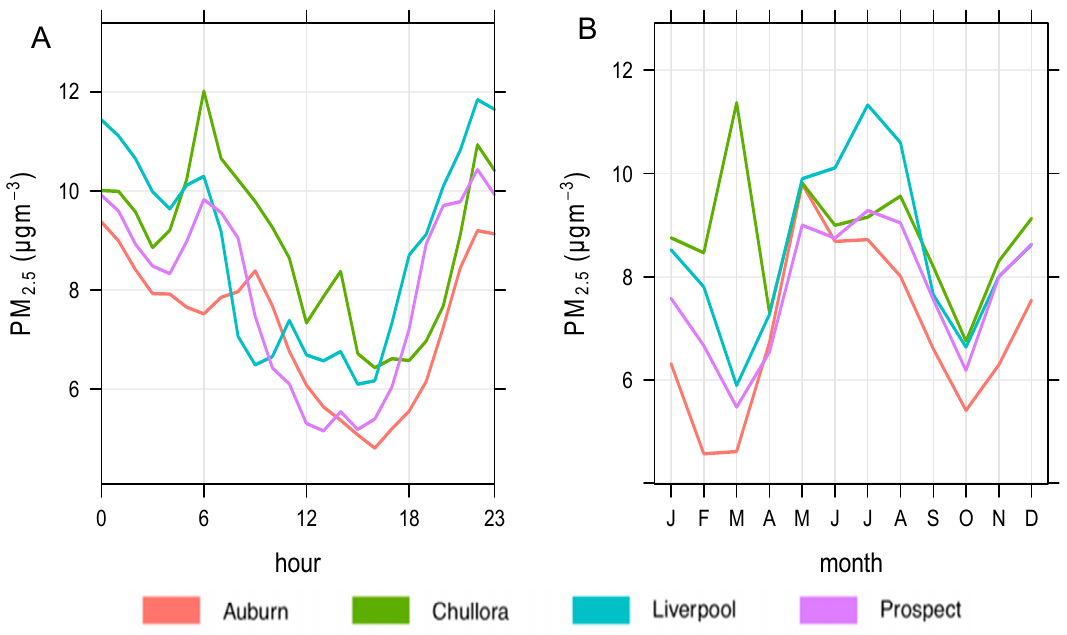
Figure 7. Hourly ( A ) and monthly ( B ) mean PM 2.5 concentration at the Auburn balcony site and the three surrounding air quality monitoring station sites; 95% confidence intervals in the mean are shaded.